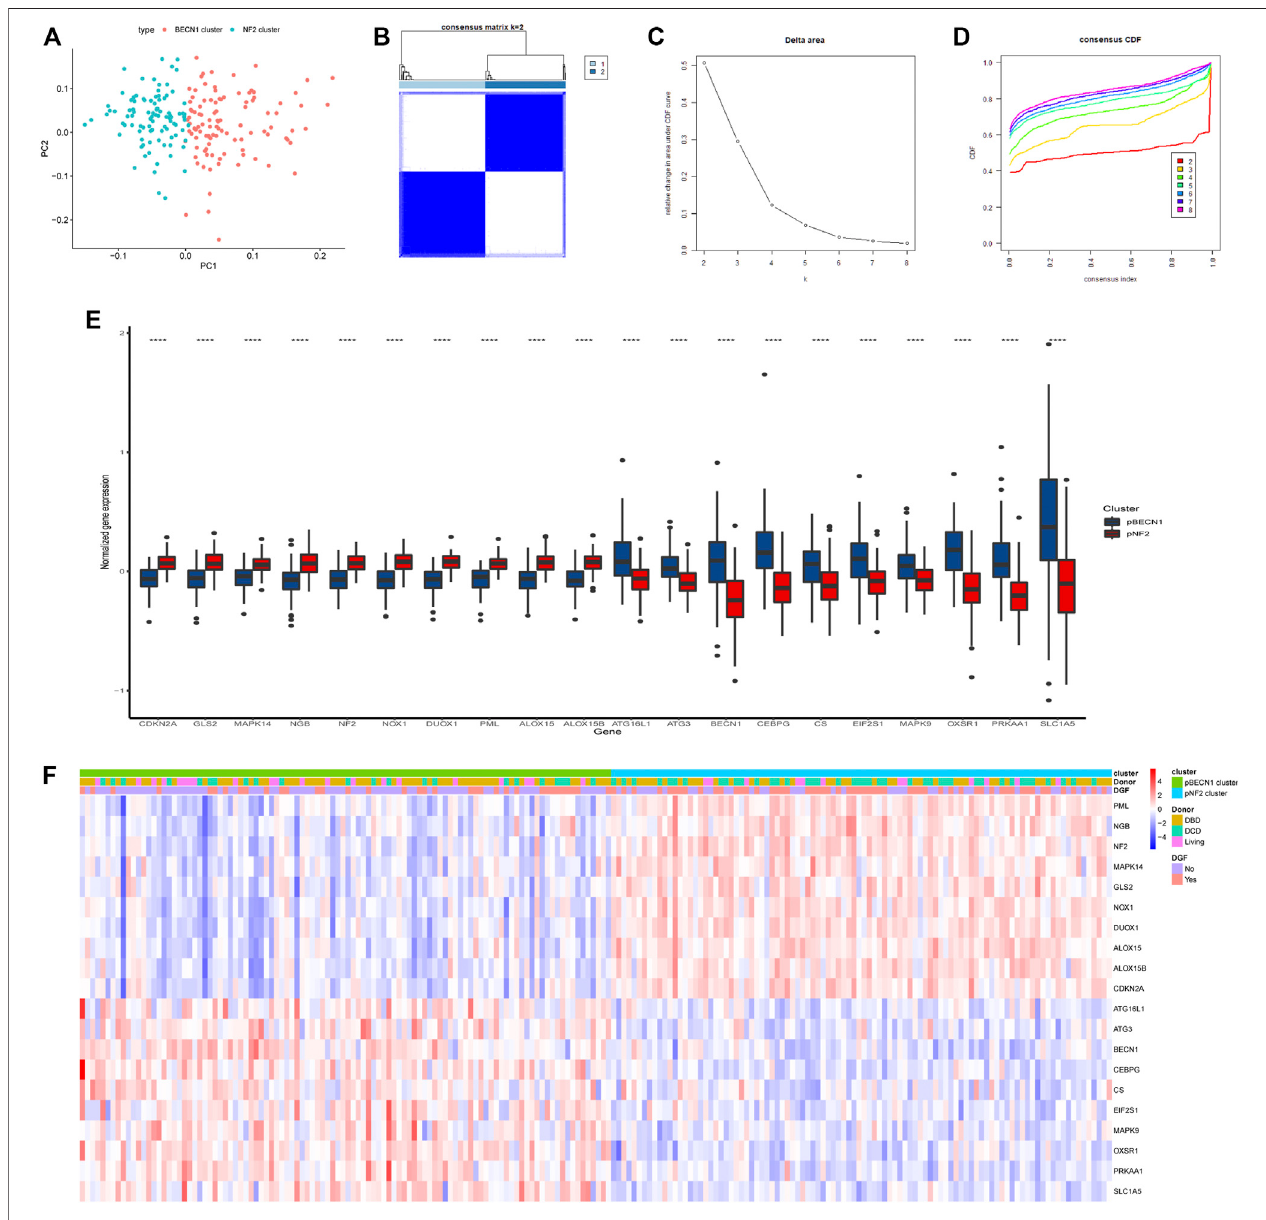
FIGURE 5 | Consensus clustering analysis strati fi ed patients into two clusters based on the top 10 correlated genes in the BECN1 gene cluster and the NF2 gene cluster. (A) Principal component analysis(PCA) showing distinct expression patterns ofthese twogene clusters. (B) Consensus matrix ofIRIsampleswhen k= 2. (C,D) ConsensusCDFandrelativechangeintheareaunderCDFcurvewhenk=2 – 8. (E) GeneexpressionleveloftopcorrelatedgenesinpBECN1andpNF2clusters.****, p < 0.0001. (F) Heatmap showing association of the pBECN1 cluster and the pNF2 cluster with donor types and occurrence of DGF. The expression of the top 10 correlated genes in each cluster was shown. The color bar showed the expression level of genes. DBD, donation after brain death; DCD, donation after cardiac death.